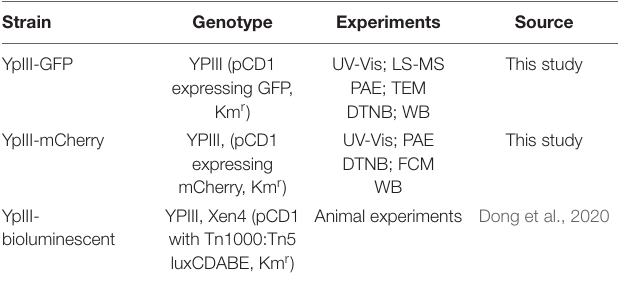
TABLE 1 | YpIII strains with different reporter